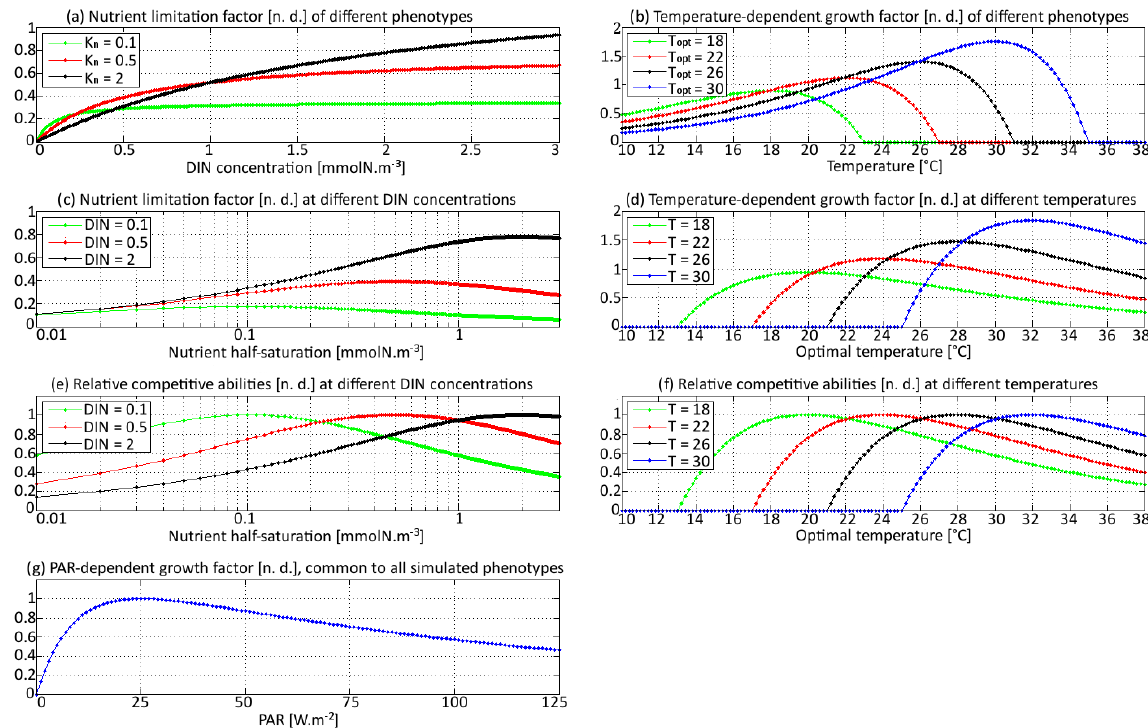
Figure 2. Phytoplankton growth factors γ n (nutrient-dependent), γ T (temperature-dependent), and γ I (PAR-dependent). Panels (a) and (b) represent the growth factor as a function of nutrient concentration and temperature, respectively, for different phenotypes. Panels (c) and (d) represent the growth factor as a function of the corresponding trait for different values of the environmental parameter. The maximum of each curve corresponds to the phenotype most adapted to a given environment. Panels (e) and (f) are normalized versions of (c) and (d) , respectively, so that their maximum is always 1. Panel (g) is the PAR-dependent growth factor, which is common to all phenotypes in this version of